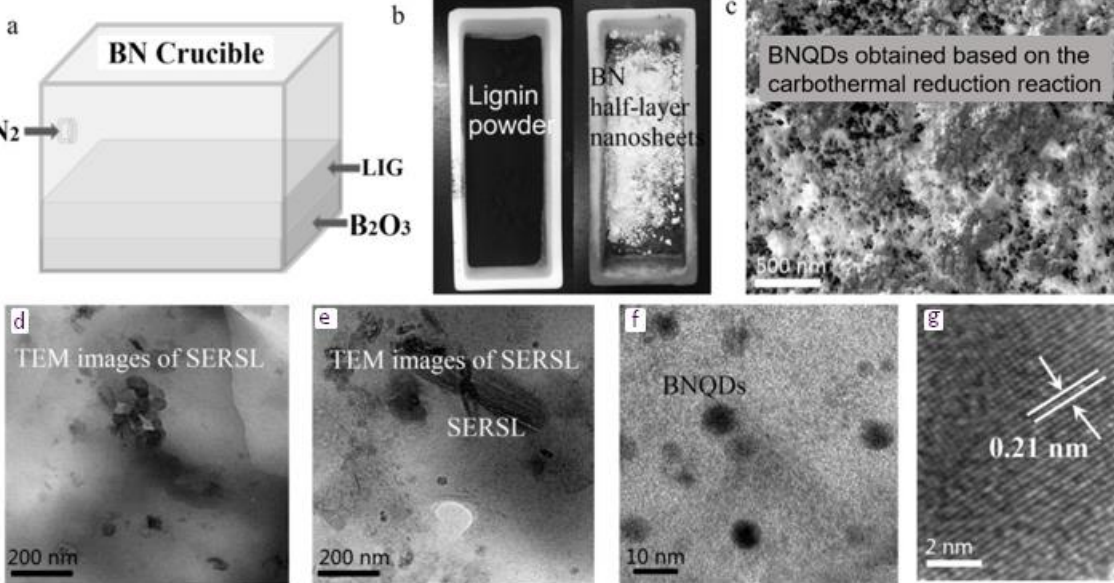
Figure 7. ( a ) Schematic for the synthesis of BN half-layer nanosheets from steam-exploded rice straw lignin (SERSL). SERSL covered the surface of B 2 O 3 powder inside the crucible and was heated at 1300 ◦ C in nitrogen atmosphere. ( b ) The optical images before (left) and after (right) reaction. The BN half-layer nanosheets were sonicated in dimethylformamide (DMF) to obtain BNQDs. ( c ) The SEM image of BNQDs. ( d , e ) The TEM images of SERSL. The low-resolution ( f ) and high-resolution ( g ) TEM images of BNQDs. Reproduced from [81] with permission from 2019 Wiley-VCH Verlag GmbH & Co. KGaA (Weinheim, Germany).